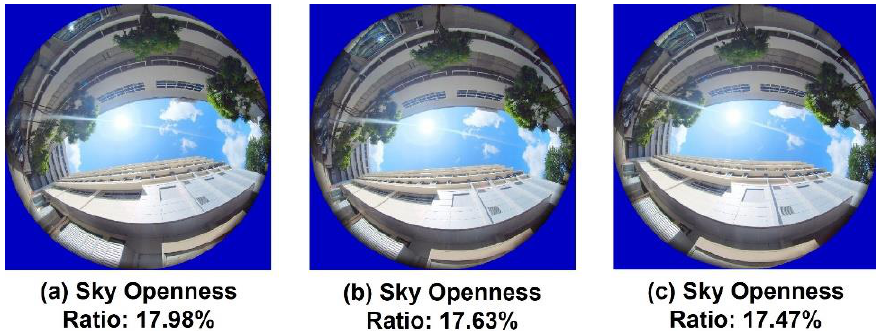
Figure 13. Hemispheric Photo Taken at 1 m Apart near N3.1 to Illustrate the (Lack of) Sensitivity of Sky Openness Ratio to Small Variation in Photo Position Relative to the Designated Photo